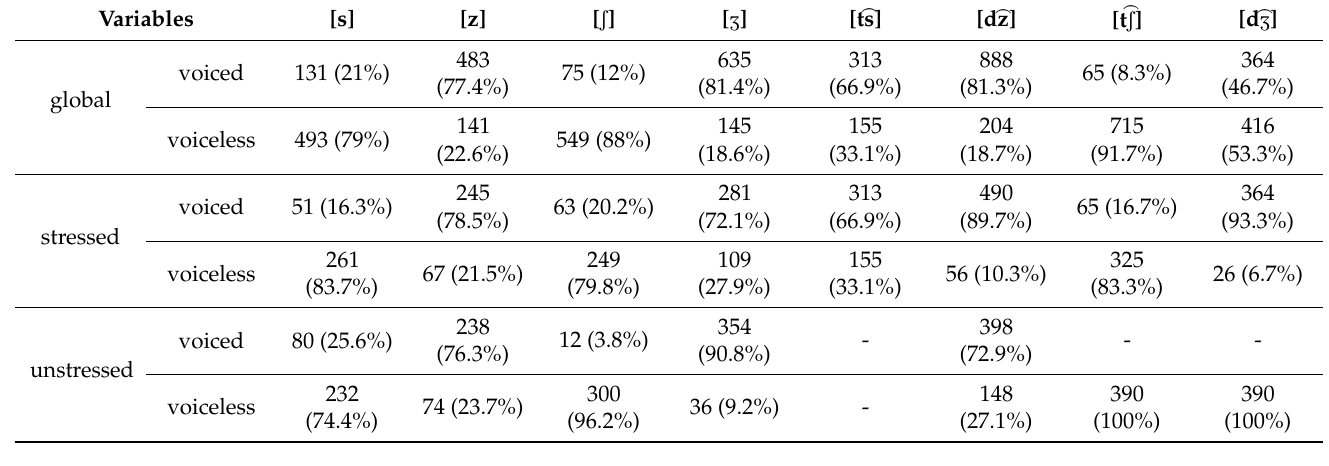
Table 8. Confusion matrix with the results of the perception test regarding phonological category and interaction between phonological category and stress. Number of responses for each item and percentages are shown.